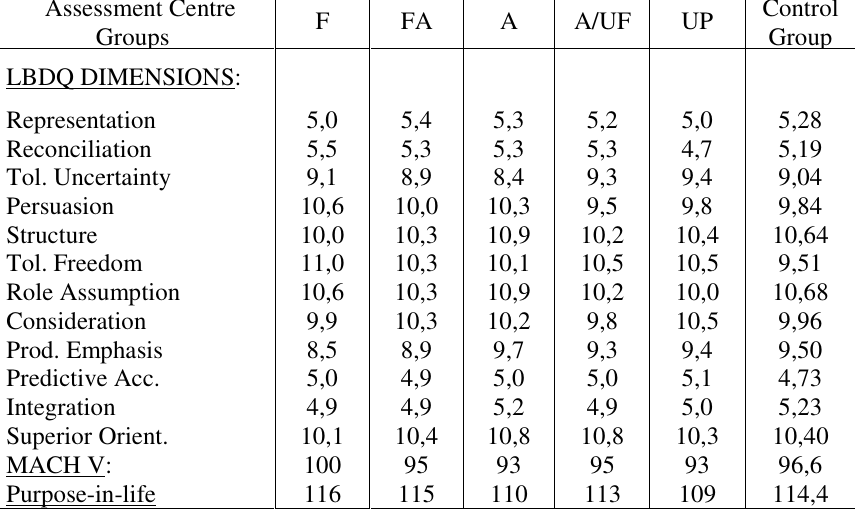
MANAGEMENT PERSONALITY PROFILE MEANS FOR EXPERIMENTAL (IN TERMS OF ASSESSMENT CENTRE INTERVALS) AND CONTROL